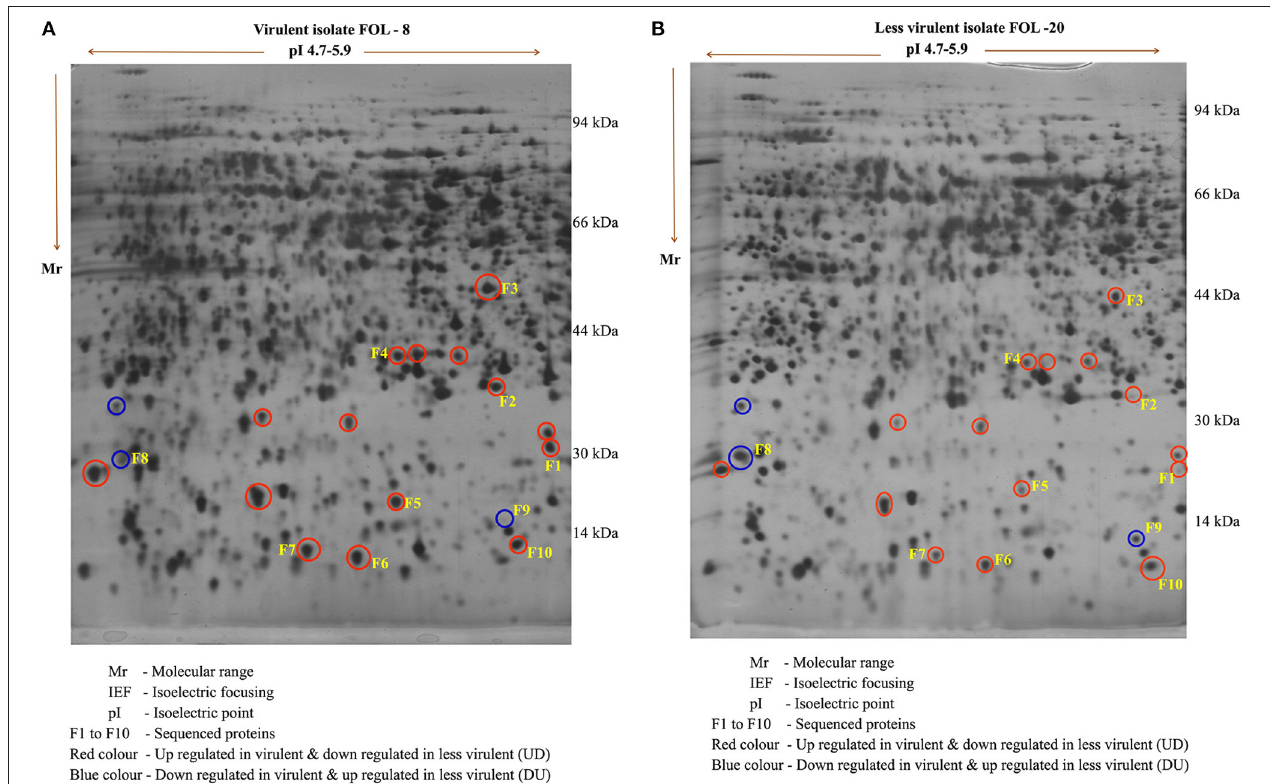
FIGURE 4 | Protein profile of F. oxysporum f.sp. lycopersici in virulent (FOL-8) and less virulent (FOL-20) isolates by 2D – gel electrophoresis. (A) Virulent isolate FOL – 8. (B) Less virulent isolate FOL –